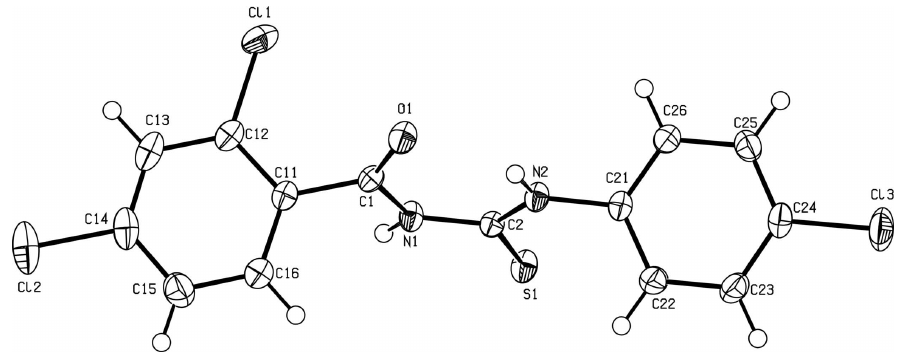
Figure 1 Molecular structure of the title compound showing atom numbering scheme. Displacement ellipsoids are drawn at the 50% probability level. H atoms are drawn as a small spheres of arbitrary radius.